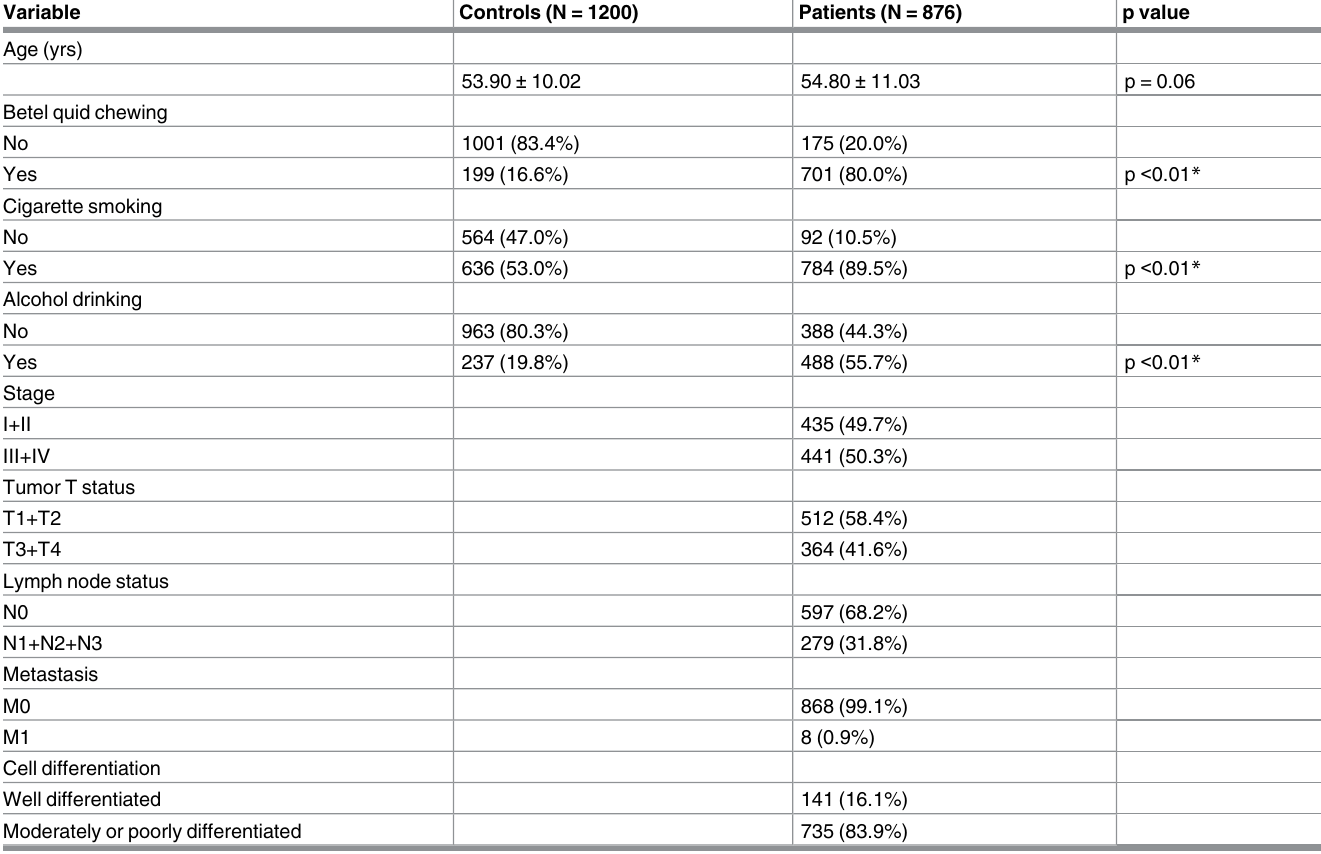
Table 1. The distributions of demographical characteristics in 1200controls and 876 male patients with oral cancer.